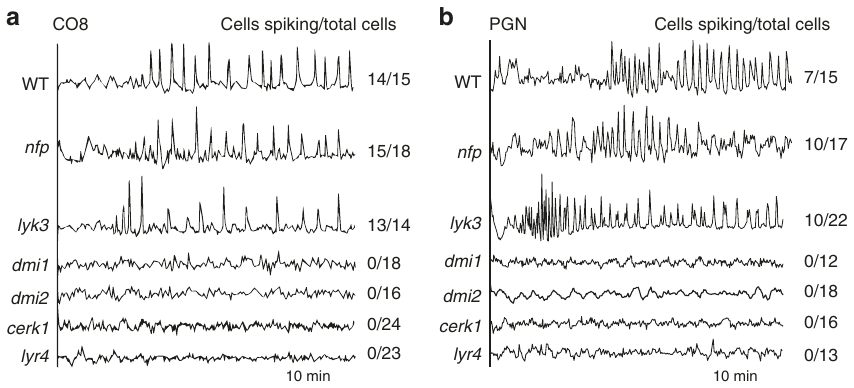
Fig. 2 CO8 and PGN activate calcium oscillations dependent on DMI1, DMI2, MtCERK1 and LYR4 . Representative calcium traces of M. truncatula trichoblasts of lateral roots responding to 10 − 8 M CO8 ( a ) and 0.8 mg/ml PGN ( b ) in wild type and different mutants. The traces denote the ratio of YFP to CFP in arbitrary units. Numbers indicate cells responding compared to total cells analyzed